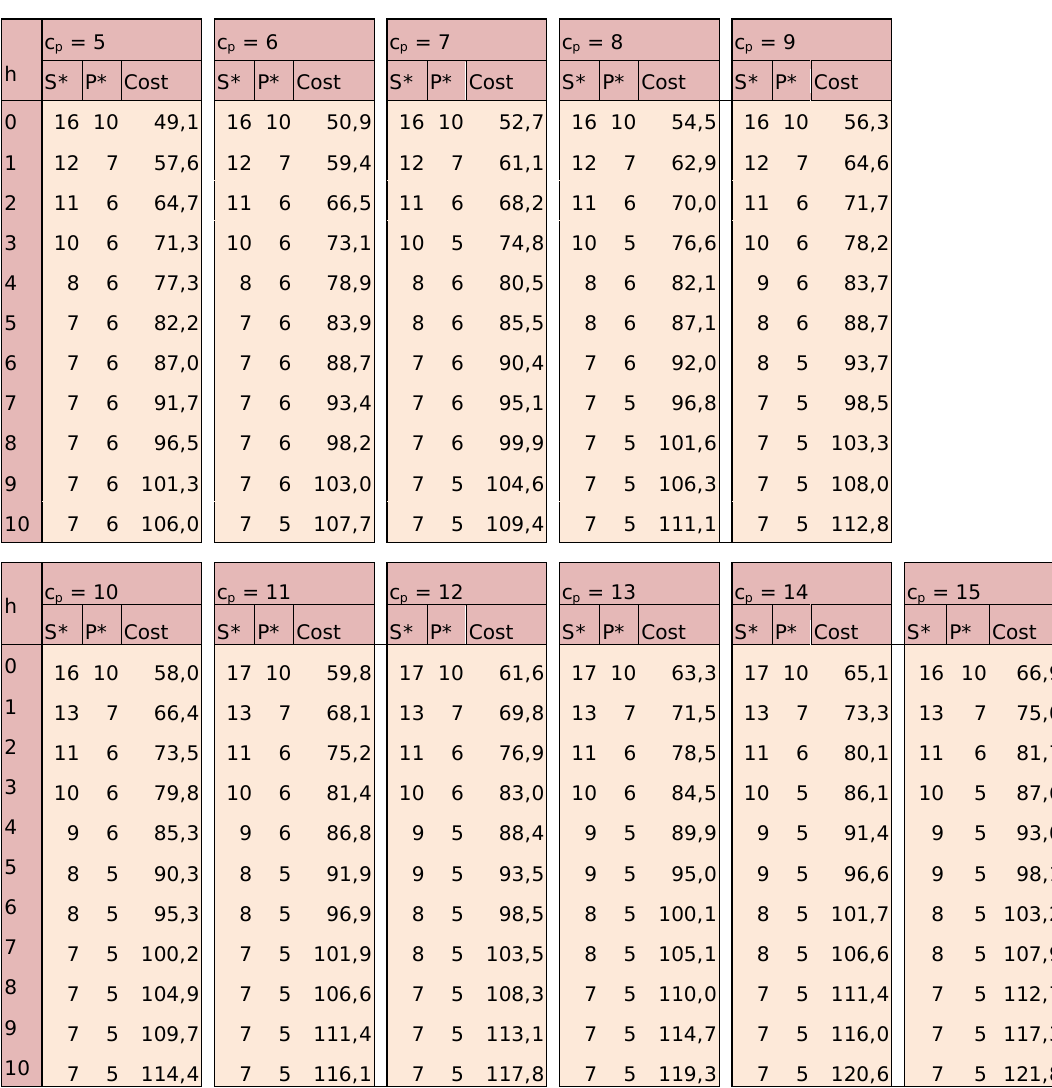
Table 1. Optimal storage and manufacturing capacities, and optimal cost for each pair ( c p , h )